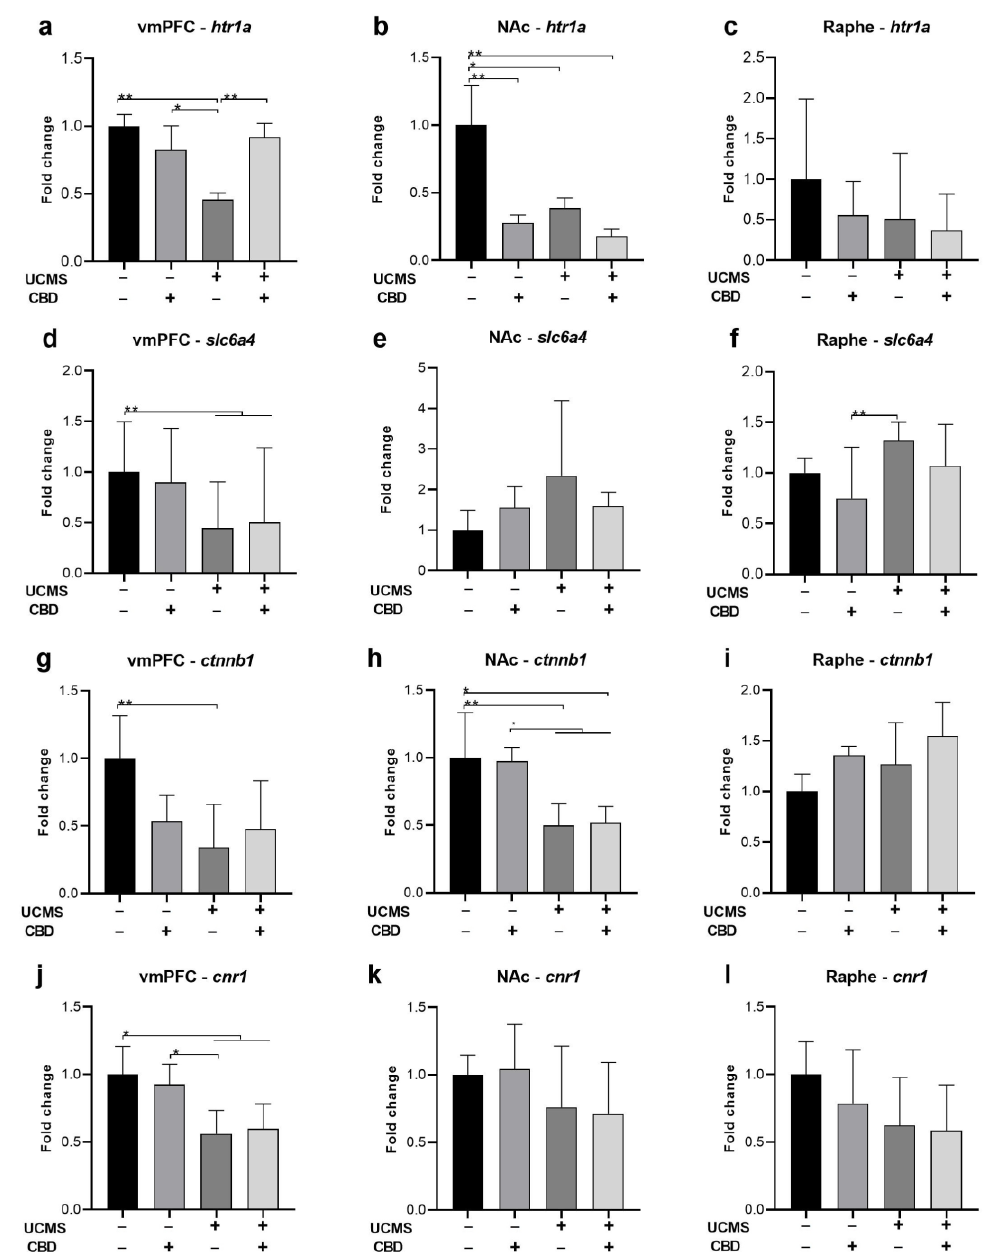
Figure 3. The effects of CBD treatment on serotonergic, β -catenin, and CB1 mRNA expression in the vmPFC, NAc, and raphe nucleus in rats exposed to UCMS. htr1a: ( a ) vmPFC: UCMS-vehicle downregulated htr1a levels compared to all groups. ( b ) NAc: UCMS rats treated with a vehicle or CBD and No UCMS rats treated with CBD demonstrated htr1a downregulation compared to No UCMS rats treated with a vehicle. ( c ) Raphe: no differences were observed between the groups. slc6a4: ( d ) vmPFC: UCMS rats treated with a vehicle or CBD demonstrated downregulation compared to No UCMS rats treated with a vehicle. ( e ) NAc: no differences were observed between the groups. ( f ) Raphe: UCMS-vehicle rats demonstrated upregulation of slc6a4 compared to No UCMS-CBD rats. Ctnnb1: ( g ) vmPFC: UCMS-vehicle rats demonstrated Ctnnb1 downregulation compared to No UCMS-vehicle rats. ( h ) NAc: UCMS downregulated Ctnnb1 compared to No UCMS rats treated with a vehicle or CBD. ( i ) Raphe: no differences were observed between the groups. Cnr1: ( j ) vmPFC: UCMS rats that were treated with a vehicle or CBD demonstrated Cnr1 downregulation compared to No UCMS rats treated with a vehicle or CBD. ( k ) NAc: no differences were observed between the groups. ( l ) Raphe: no differences were observed between the groups. vmPFC: